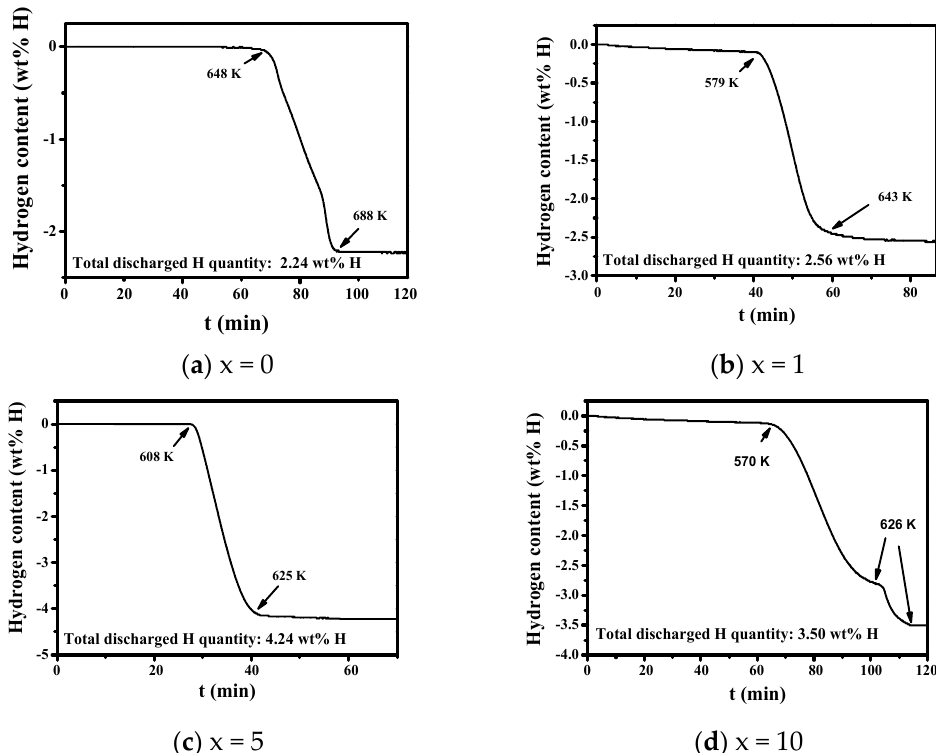
Figure 3. Desorbed hydrogen quantity versus time t curves for the as-milled Mg-xMgH 2 -1.25Ni-1.25TaF 5 -1.25VCl 3 ; ( a ) x = 0, ( b ) x = 1, ( c ) x = 5, and ( d ) x = 10 when the sample was heated with a heating rate of 5–6 K/min. The versus curves at under at = for Mg-xMgH 2 -1.25Ni-1.25TaF 5 -1.25VCl 3 (x = 0, 1, 5, and 10) are shown in Figure 4. The sample with x = 0 has a quite high hydriding rate for the first 5 min, and the samples with